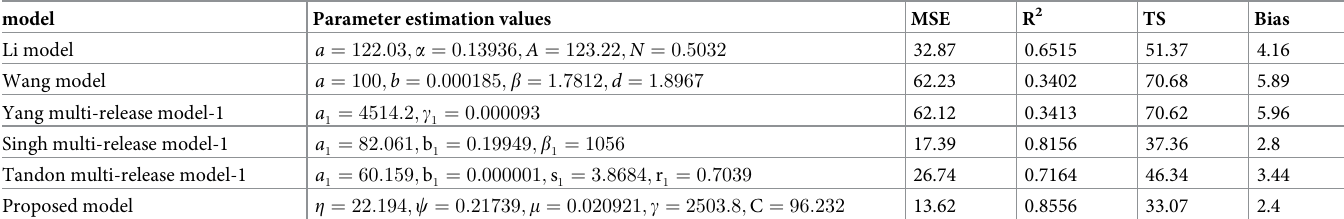
Table 2. Comparison of the fitting performance of models using 100% of fault data (DS1-1). model Parameter estimation values